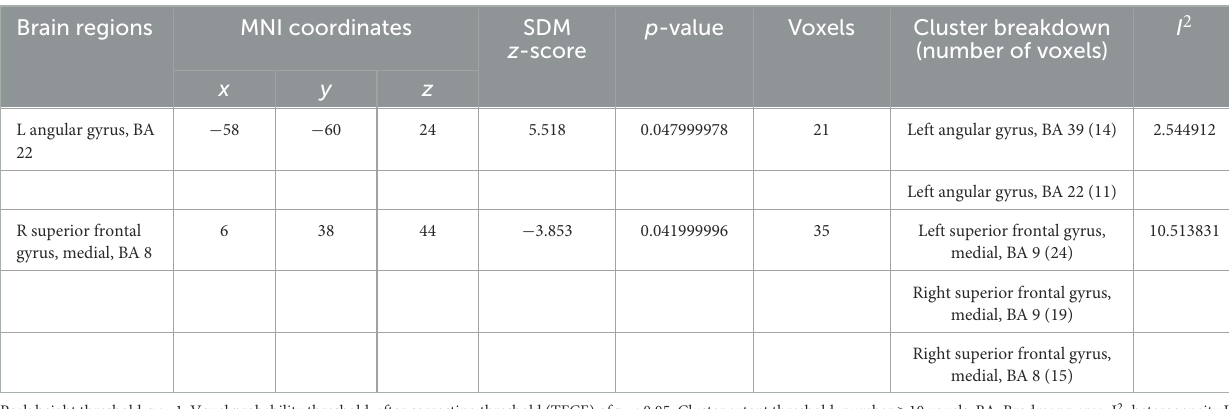
TABLE 3 Brain activity changes in patients PRE and POST acupuncture treatment in the coordinate-based meta-analysis.